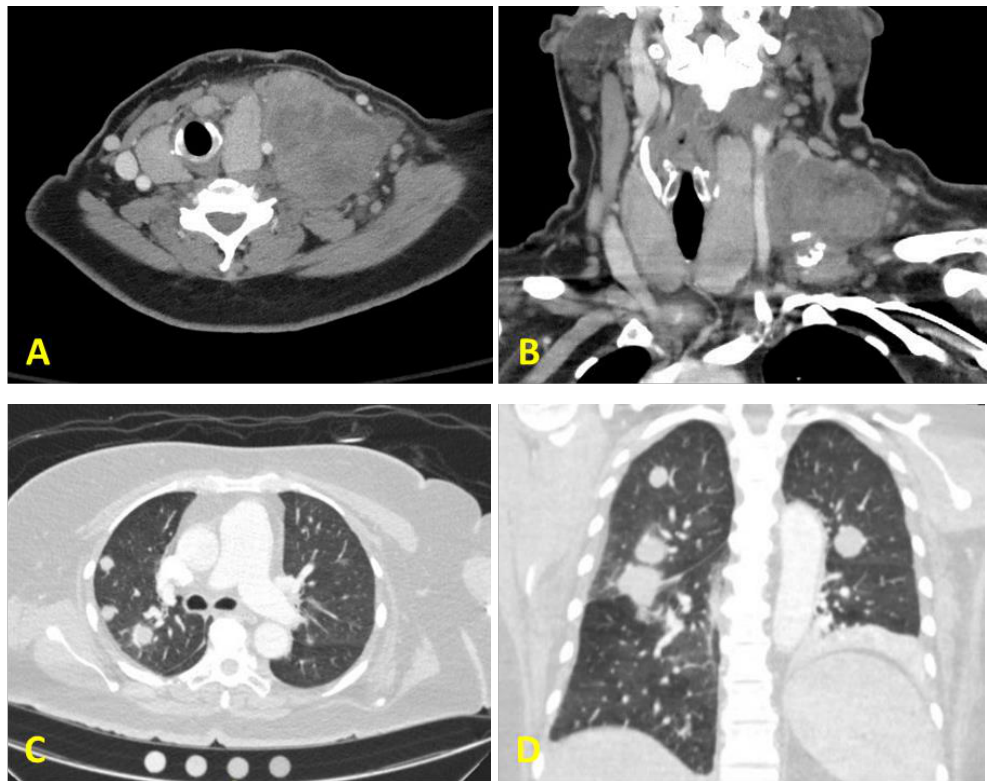
Figure 1. Computed tomography (CT) scan of the patient’s neck showing a large mass located at the level 4, with central cystic necrosis (( A ): cross section and ( B ): coronal section). Axial section ( C ) and coronal section ( D ) taken from a CT angiogram of the chest showing metastatic lung lesions.